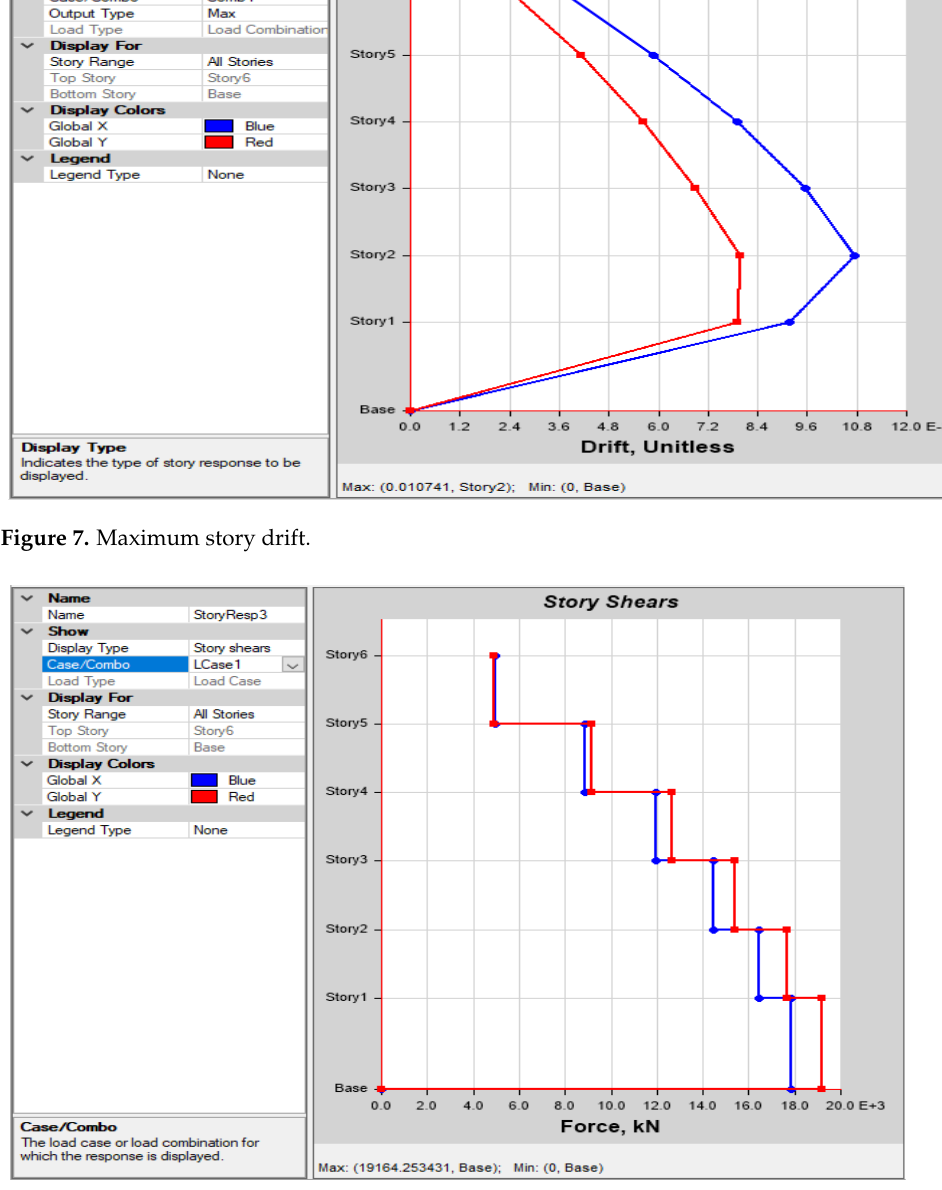
Figure 8. Story shears.